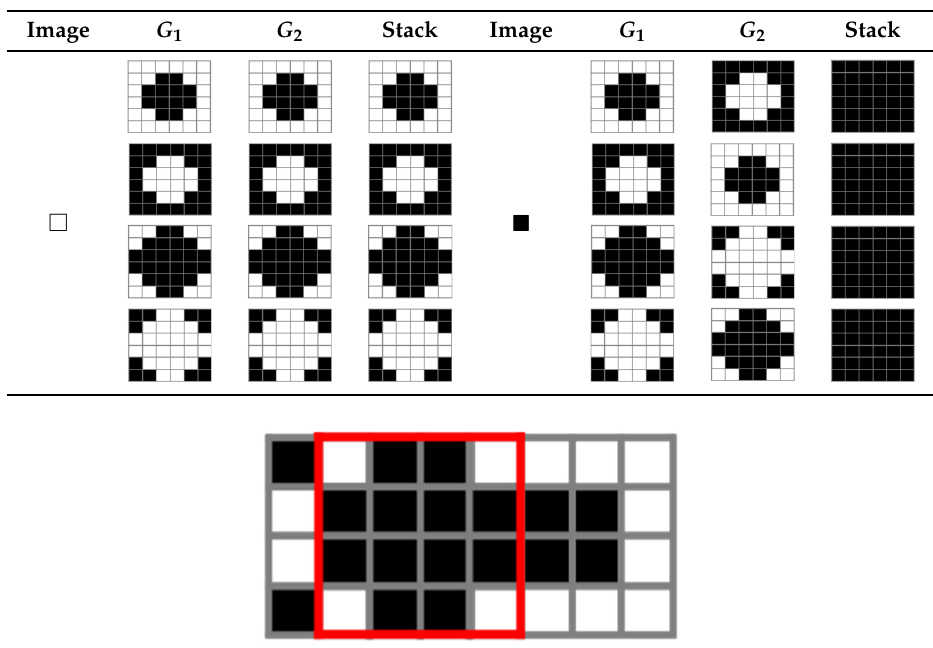
Figure 3. Stacked image with one pixel right shifted.